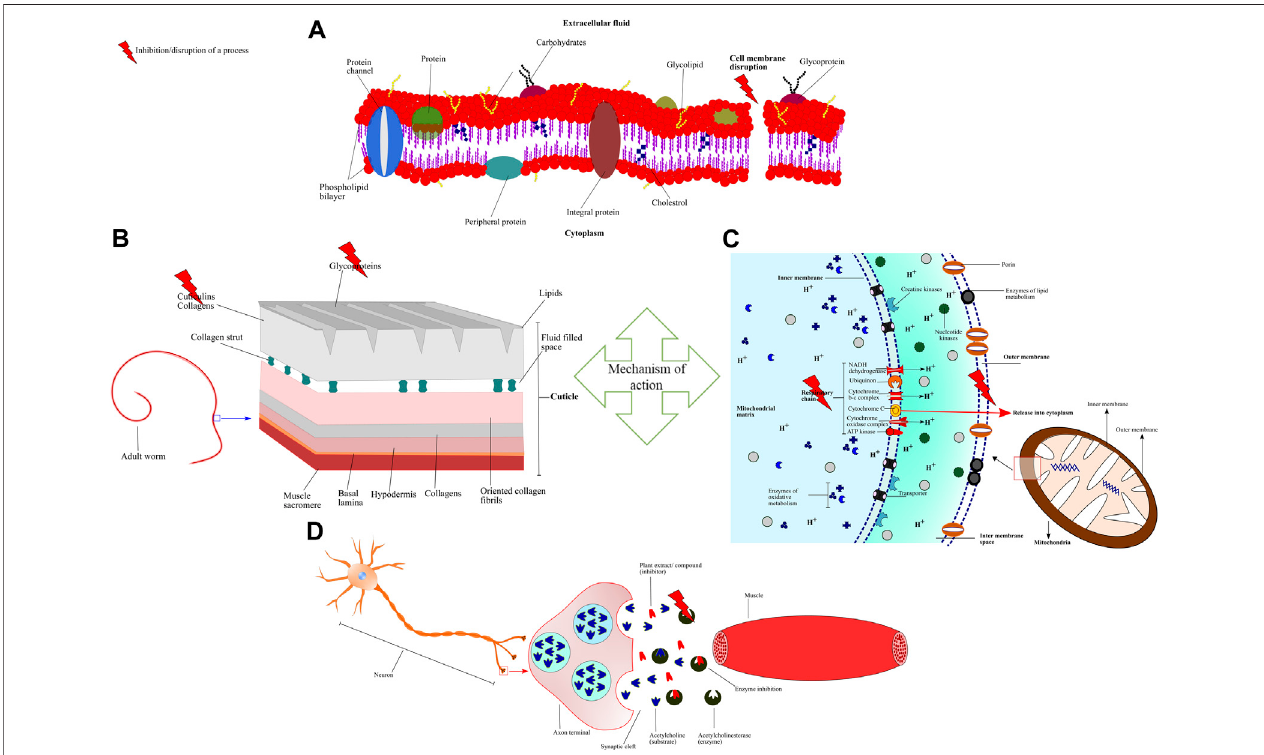
FIGURE 6 | Schematic representation of mechanism of action and different pharmacological targets of plant extracts/compounds (A) Essential oils alter the permeability and cause depolarization of cytoplasmic membrane by interacting and disrupting the chemical structures of lipids, polysaccharides, and phospholipids (B) Condensed tannins (CT) bind to the cuticle proteins thus, inducing chemical and physical damage (C) Artemisinin disrupts the mitochondrial membrane potential and releases cytochrome c into the cytoplasm leading to inhibition of electron transfer and oxidative phosphorylation (D) Allium sativum inhibits Acetylcholinesterase (AChE) that hydrolyzes the neurotransmitter acetylcholine. Inhibition of ACheE leads to the accumulation of acetylcholine at the synaptic junction and disrupting the neuromuscular transmission which causes muscle paralysis.